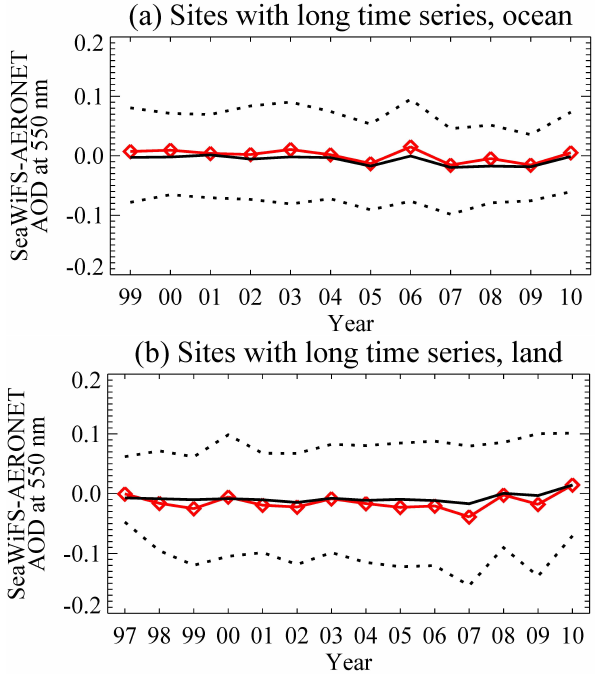
Fig. 2. Yearly variations in the differences between SeaWiFS and AERONET AOD over (a) ocean and (b) land. Red is the mean dif- ference in each year, while solid black is the median for each year. Dotted black are the range of the central 68% of the